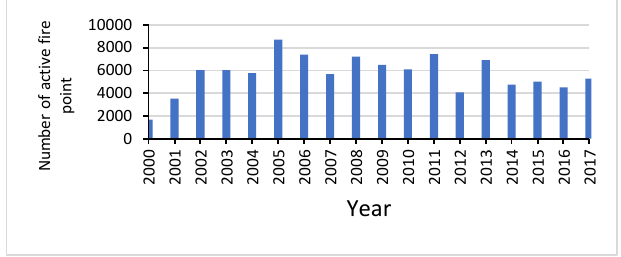
Figure 8: Annual evolution of active fires from 2000 to 2017